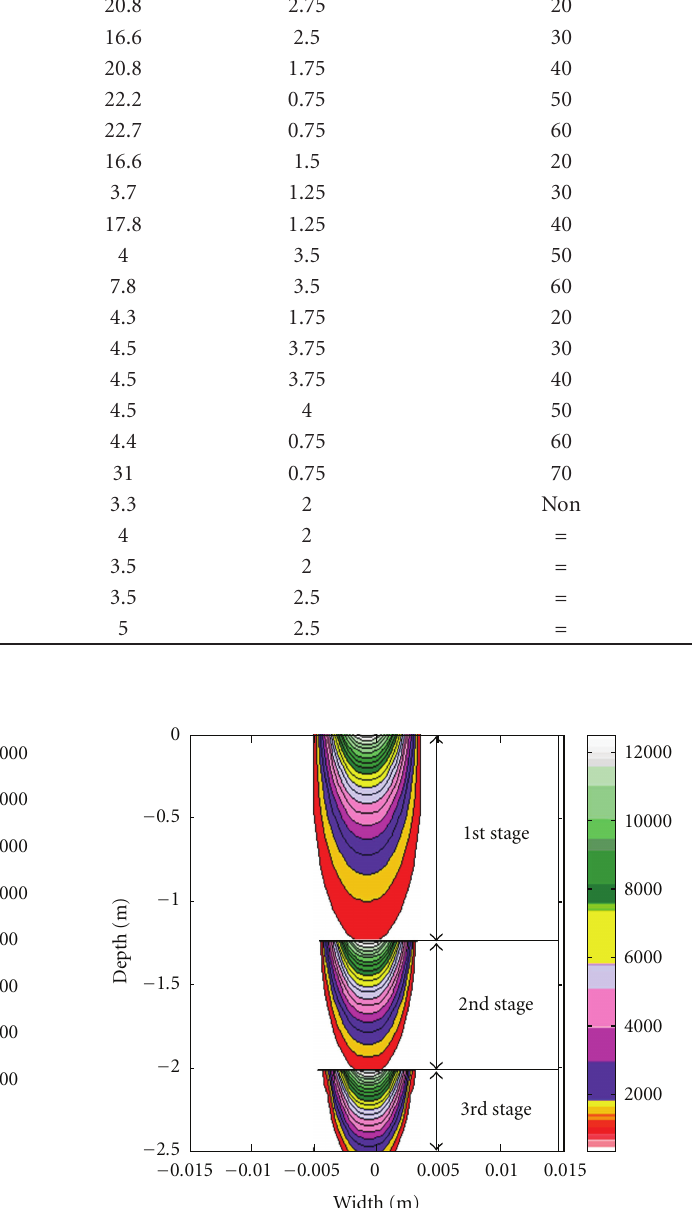
Figure 9: The first-stage temperature distribution; exposure time (s) = 2 . 25, total power ( W ) = 1 . 82, and surface temperature = 1 . 1413e + 004. The second-stage temperature distribution; expo- sure time ( s ) = 2 . 25, total power ( W ) = 0 . 2953, and surface temperature = 1 . 8518e + 003. The third-stage temperature distribution; exposure time ( s ) = 2 . 25, Total power ( W ) = 0 . 19, and surface temperature = 1 . 2559e +